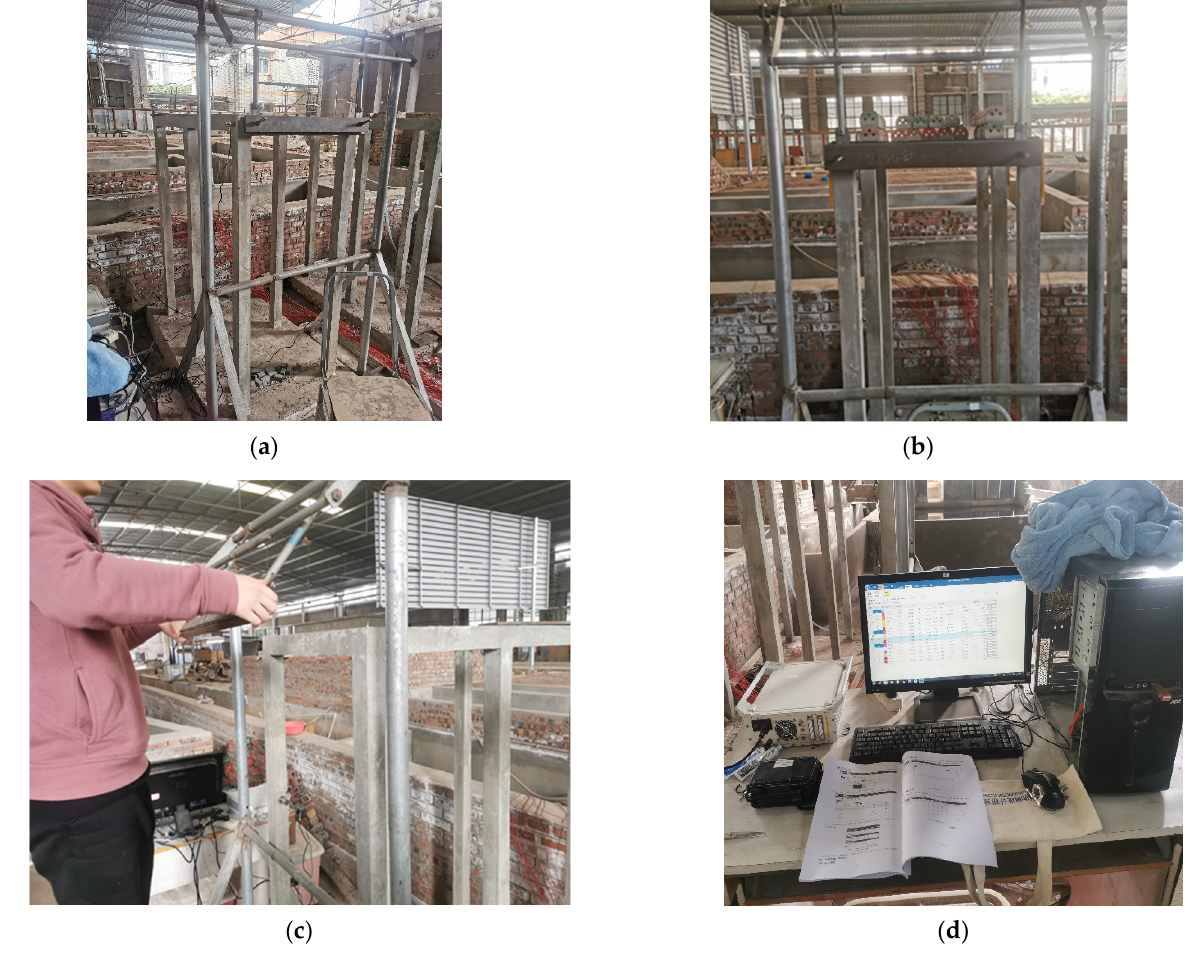
Figure 12. Dock frame structure simulating ship impact test process. ( a ) Sensor arrangement; ( b ) dynamic load of impact and pile load simulation setting; ( c ) impact way; ( d ) test data acquisition system.